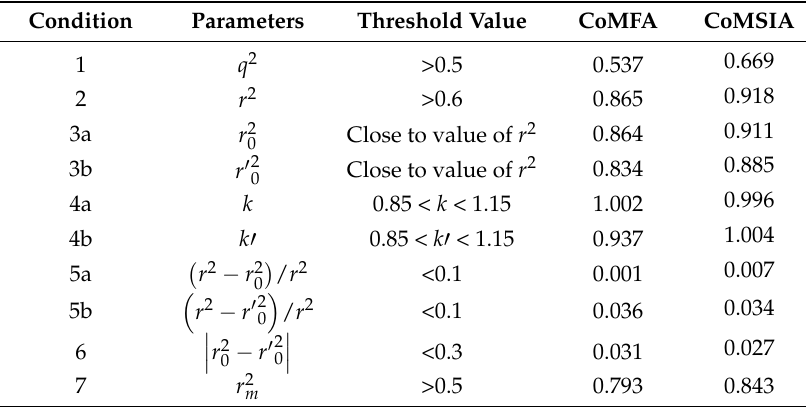
Table 2. Summary of external validation parameters for CoMFA and